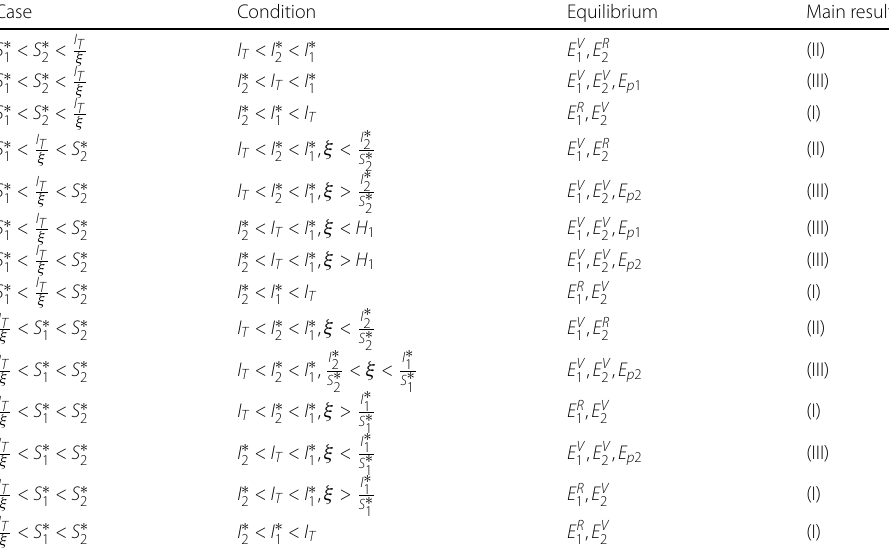
Table 2 Global dynamics of system (1)–(2) summarized from Sects. 3, 4, and 5 Case Condition Equilibrium Main